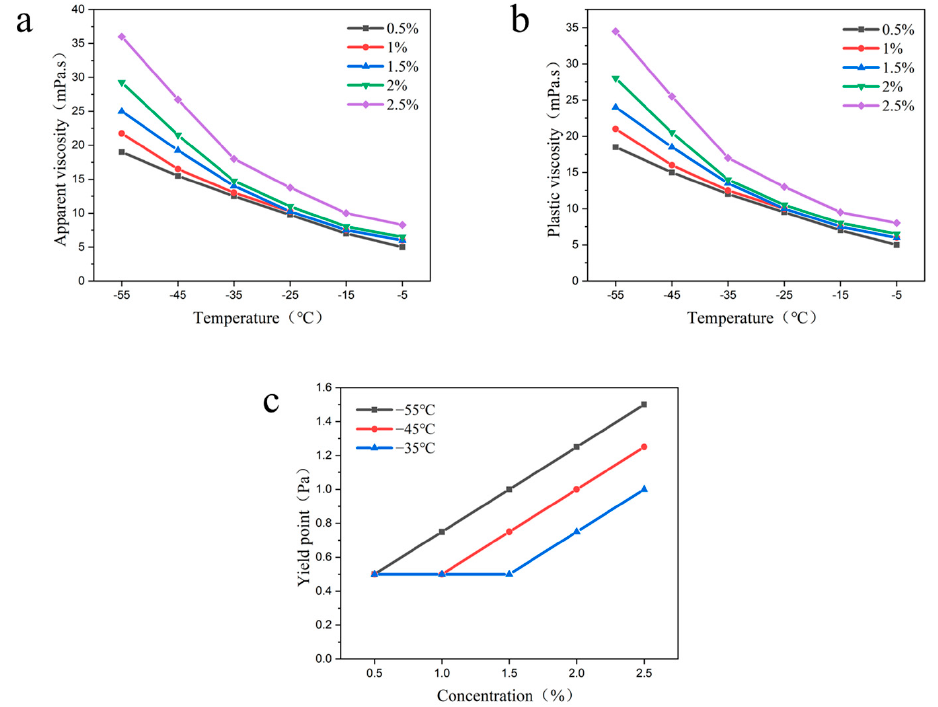
Figure 8. Effects of the different concentrations of ethylene propylene copolymer on the rheological properties of drilling fluid; ( a ) apparent viscosity; ( b ) plastic viscosity; ( c ) yield point.